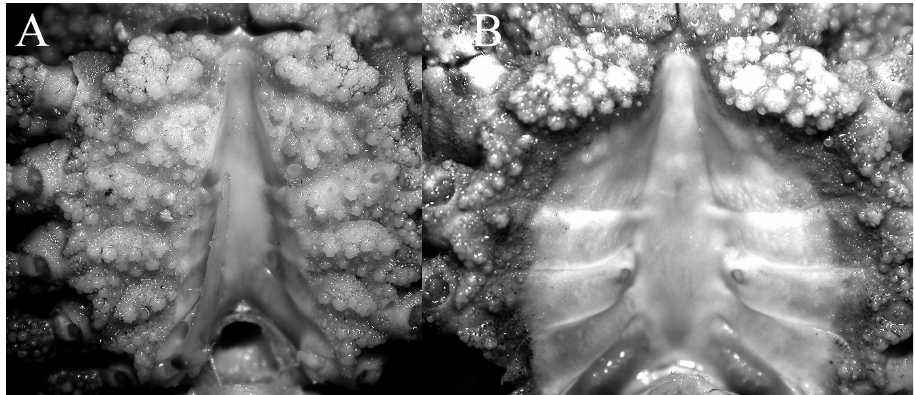
Figure 10. Pariphiculus stellatus sp. n. A holotype male (27.7 × 24.5 mm) (ASIZ 75485), Taiwan B fe- male (31.1 × 26.2 mm) (ZRC 2017.188), Philippines. A male sternopleonal cavity showing right G1 and pleonal locking tubercle on sternite 5 B female sternopleonal cavity showing vulvae on sternite